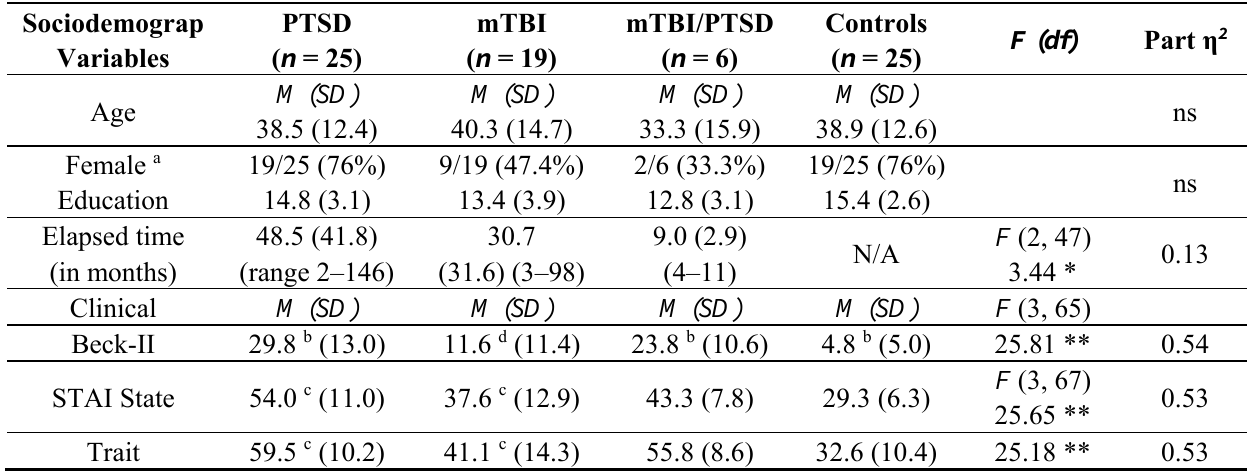
Table 1. Summary of Control and Clinical Variables.